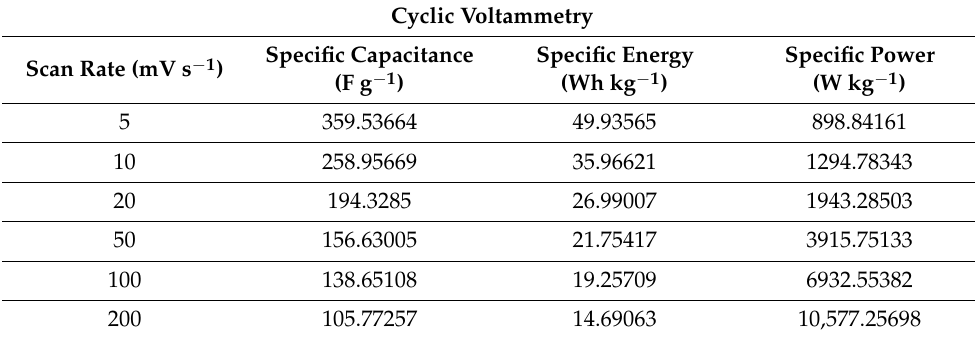
Table 2. Electrochemical results of FCNT-MnO 2 hybrid from cyclic